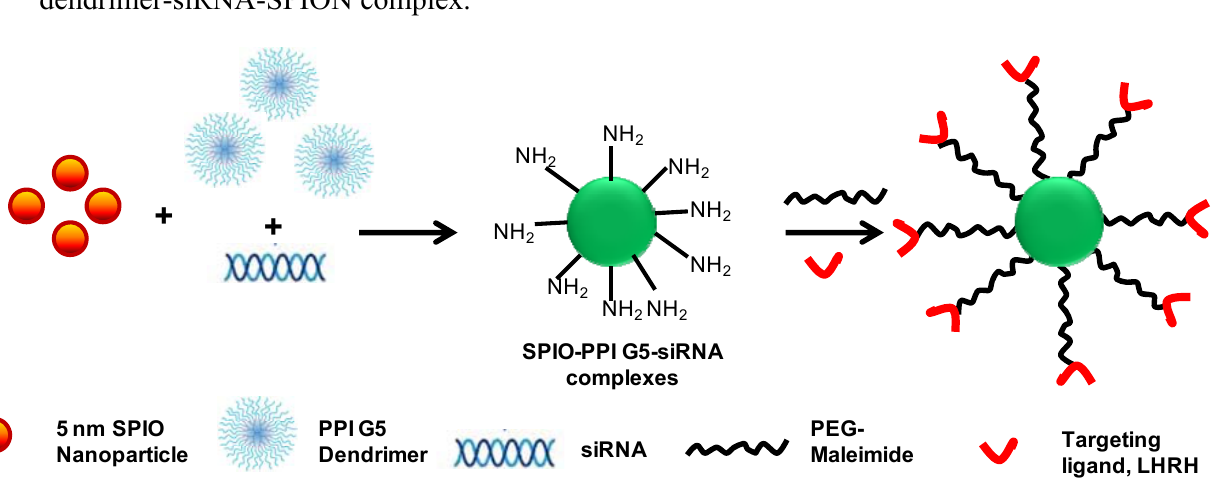
Figure 4. Schematic representation of the development of a cancer cell-targeted dendrimer-siRNA-SPION complex.